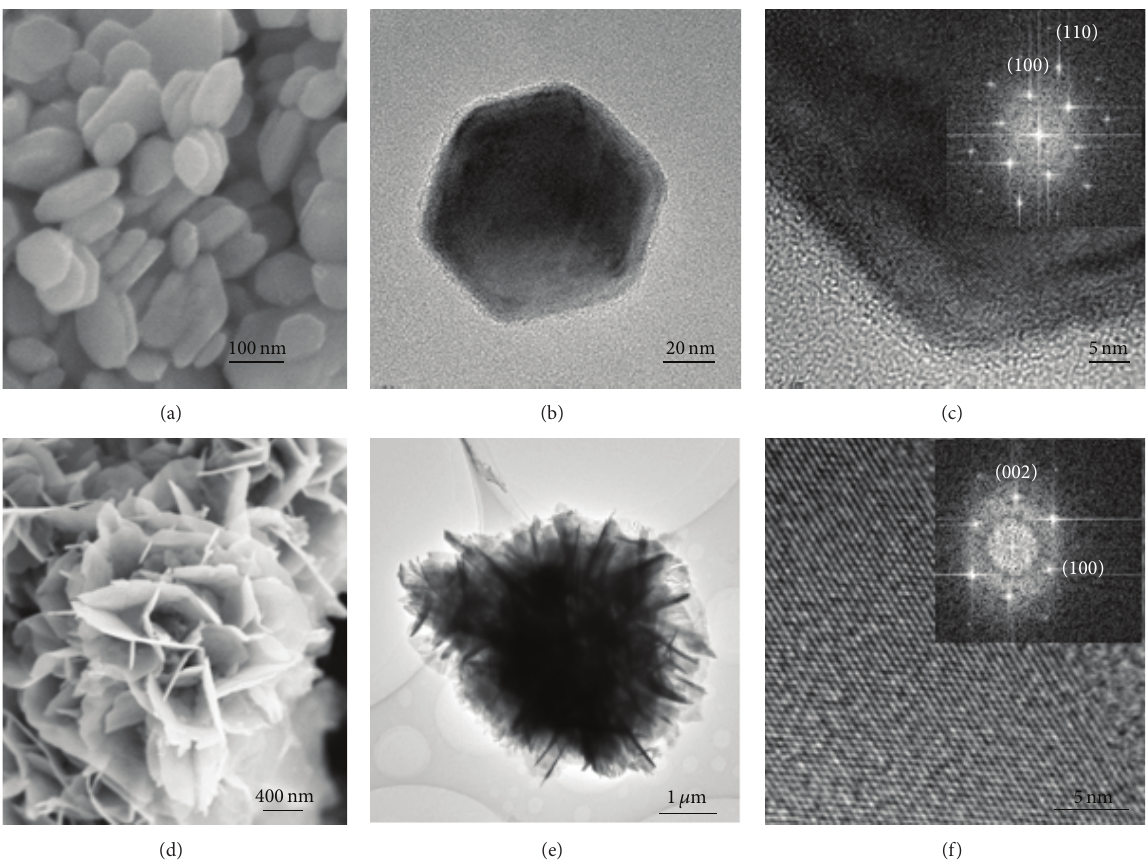
Figure 3: SEM, TEM, and HRTEM images of the sheetlike SnS 2 ((a)–(c)) and flowerlike SnS 2 ((d)–(f)). The inset in (c) and (f) is the fast Fourier transform patterns corresponding to the respective HRTEM images.